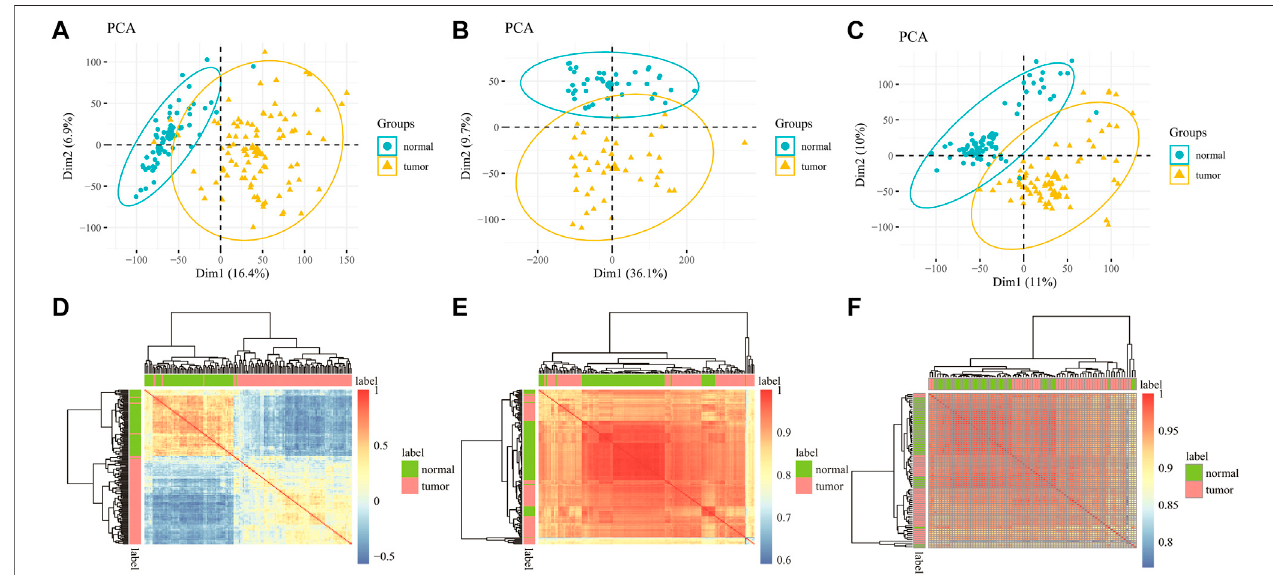
FIGURE2| PCAforallsamplesinthe (A) GSE19188 (B) GSE139032and (C) GSE49996datasetindicatedtwodifferentgroups.Pearsoncorrelationmatrixamong all samples in (D) GSE19188 (E) GSE139032 and (F) GSE49996.